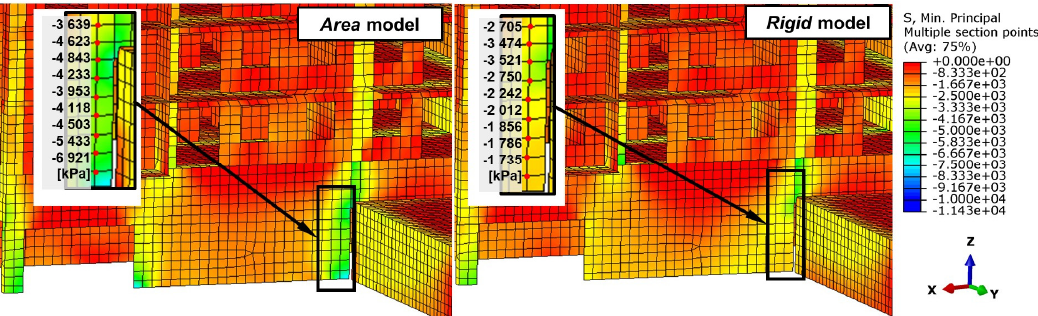
Figure 22. A comparison of the minimum principal stress maps [kPa] at the garage entrance in segment A in the AREA and RIGID models.